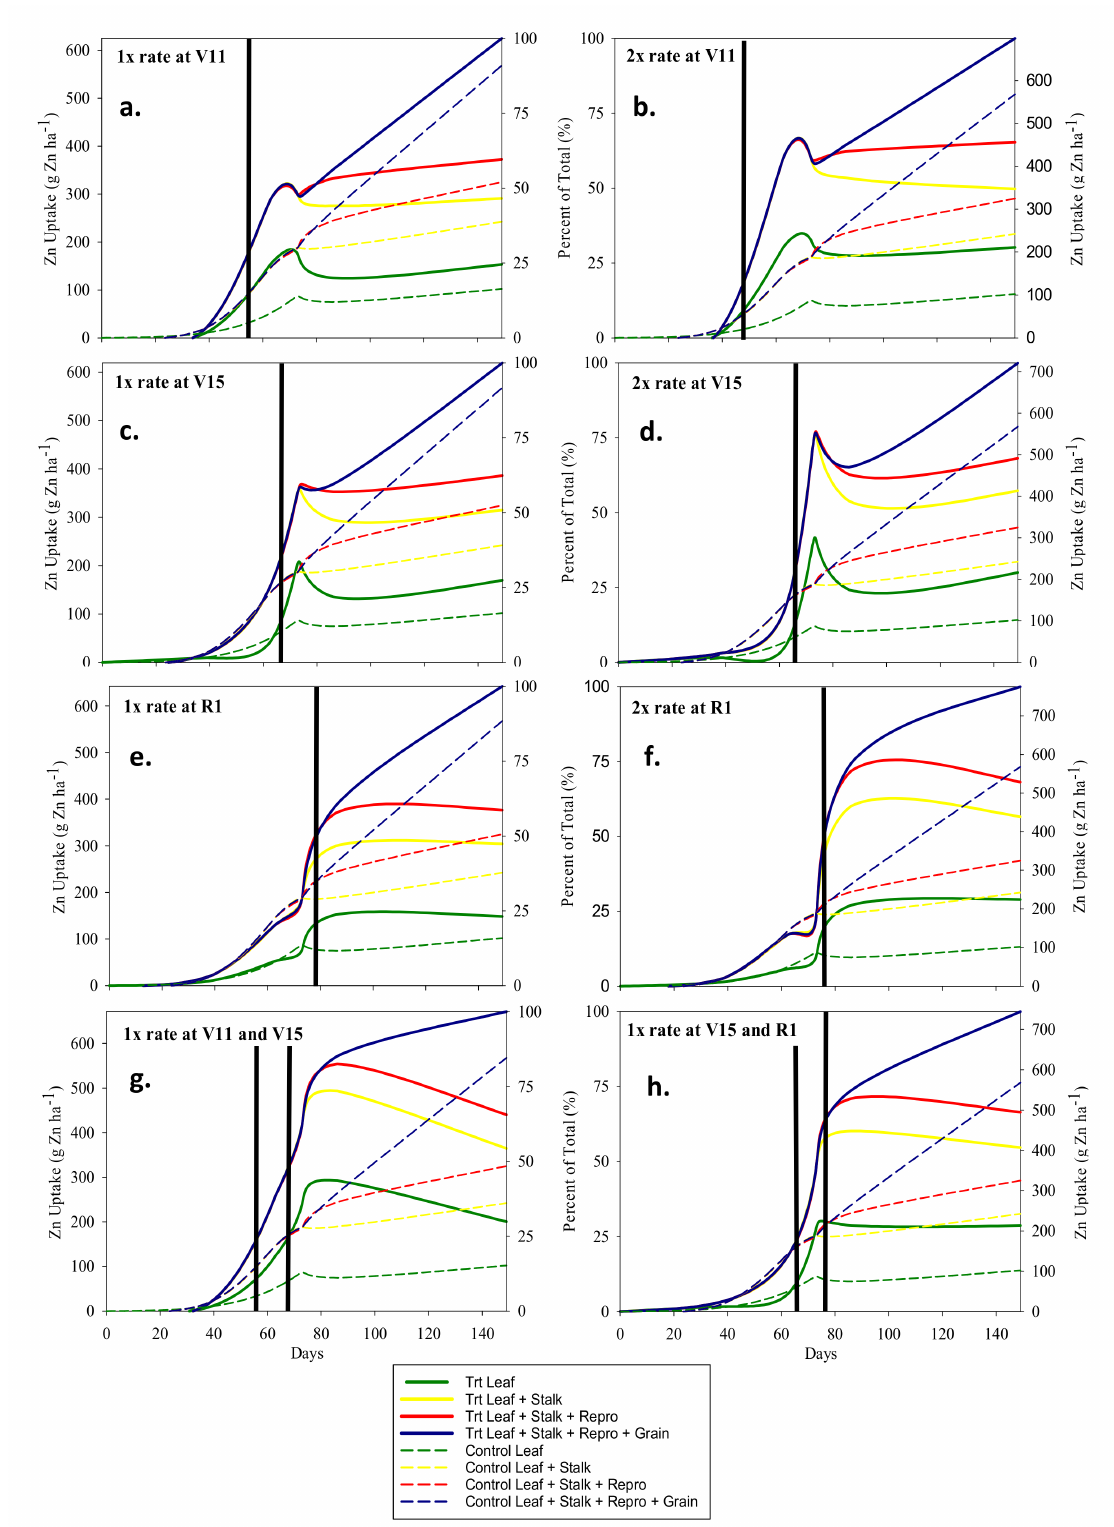
Figure 2. Zn uptake (g Zn ha − 1 ) and partitioning graphs. Solid and dashed lines represent foliar Zn treated plots and control plot, respectively. Solid vertical lines represent the time of application expressed as days after sowing. ( a – h ) corresponds with the